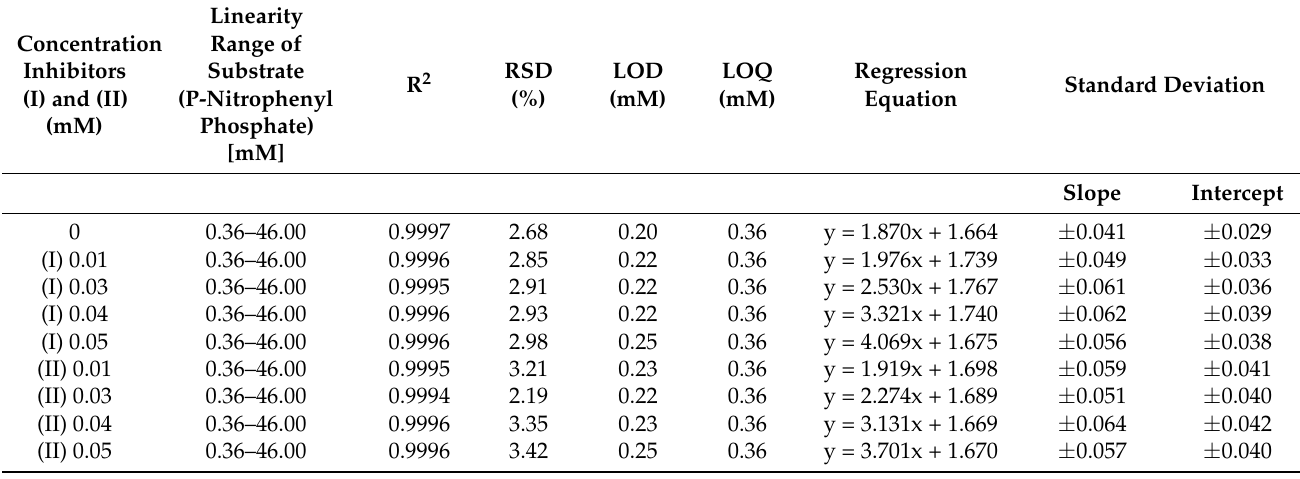
Table 1. Regression equation and quantification for p-nitrophenyl phosphate for 6 replicates for each sample ( n = 6) in the concentration range 0.36–46.00 mM, in the presence of inhibitors (I) and (II) at a concentration of 0.01, 0.03, 0.04 and 0.05 mM.